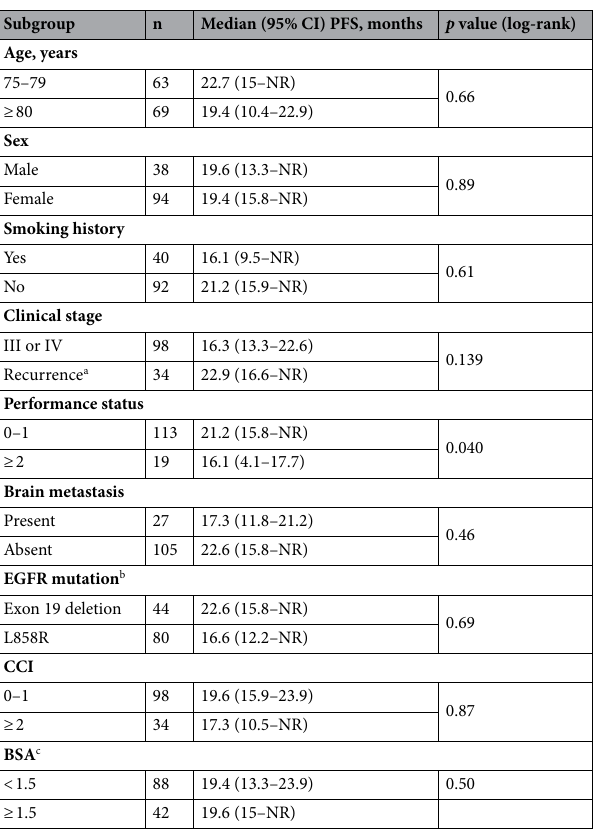
Table 3. Progression-free survival (PFS) according to different subgroups. BSA body surface area, CCI Charlson comorbidity index, CI confidence interval, EGFR epidermal growth factor, receptor, NR not reached. a Recurrence after complete resection or curative-intent (chemo) radiotherapy. b Patients could have more